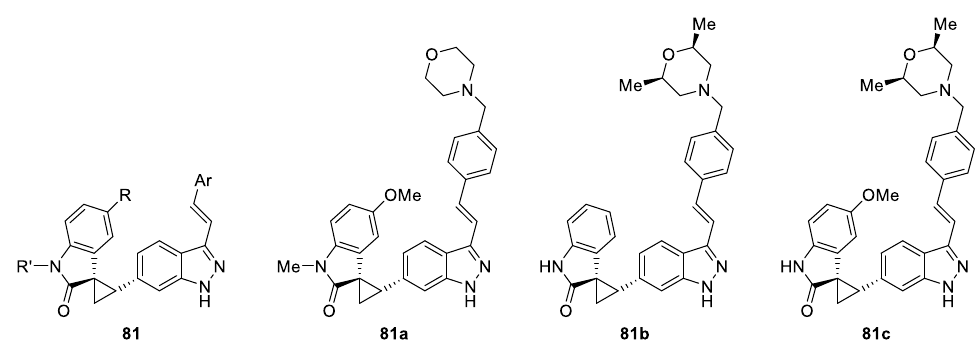
Figure 3. Chemical structures of (1R,2S)-2-(1 H -Indazol-6-yl)spiro[cyclopropane- 1,3’ -indolin] - 2’ -one derivatives 81a - c.